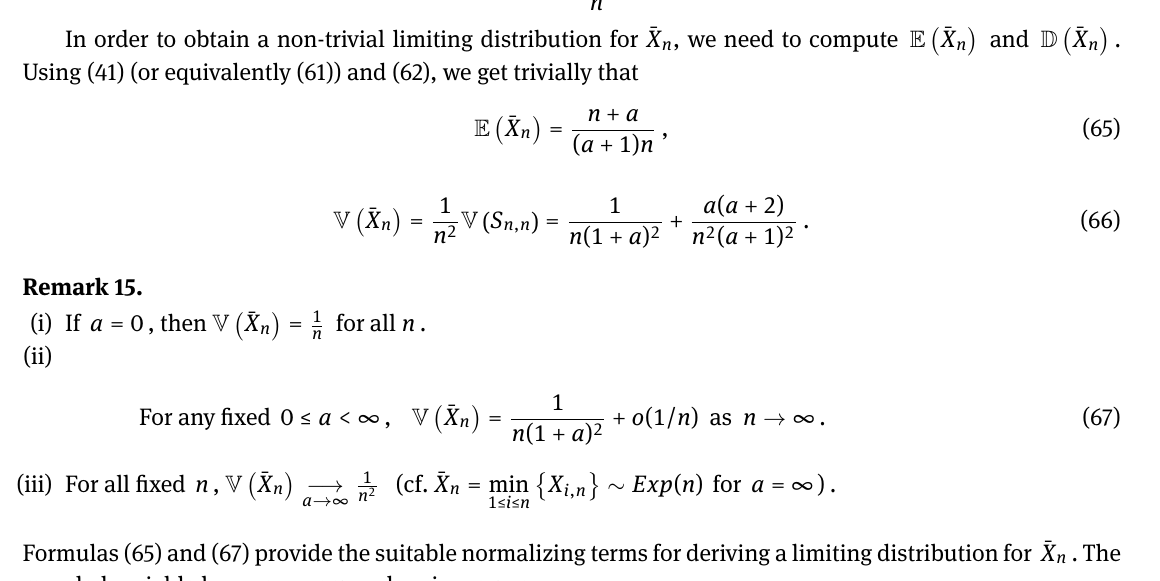
− ˜ g 50 (cid:107) (cid:117) 0.0141 , (cid:107) g − ˜ g 100 (cid:107) (cid:117) 0.0059 . The mode of ˜ Y S 50 S 100 n , n